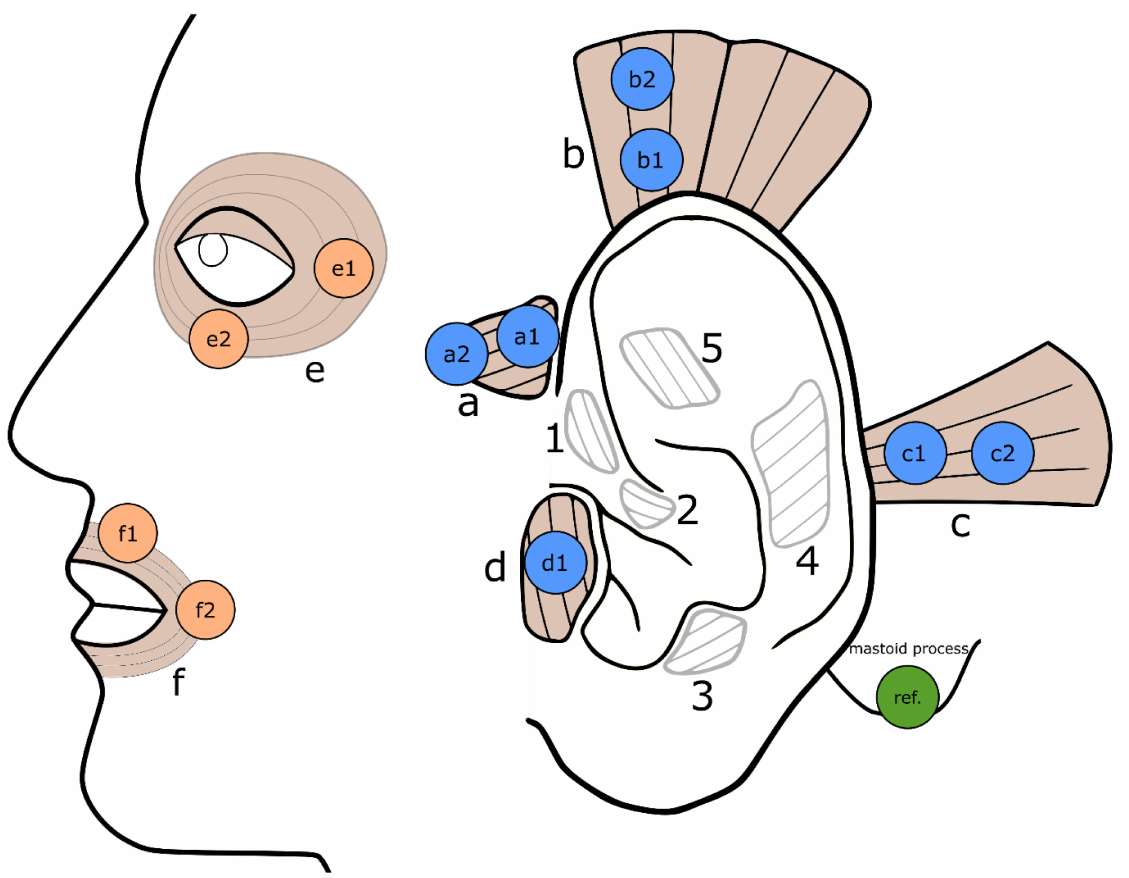
Figure 1. Electrode positioning on the auricular and mimic muscles. a = anterior auricular muscle (AAM); b = superior auricular muscle (SAM); c = posterior auricular muscle (PAM); d = tragicus muscle (TM); e = orbicularis oculi muscle (OOcM); f = orbicularis oris muscle (OOrM); 1–5: other auricular muscles, which are not relevant for this study. Electrodes are placed on auricular muscles (blue circles) and mimic muscles (orange circles). A reference electrode (green circle) is placed on the mastoid process; common ground is placed on the spinous process of C7 (not depicted). Electrodes were placed symmetrically on both